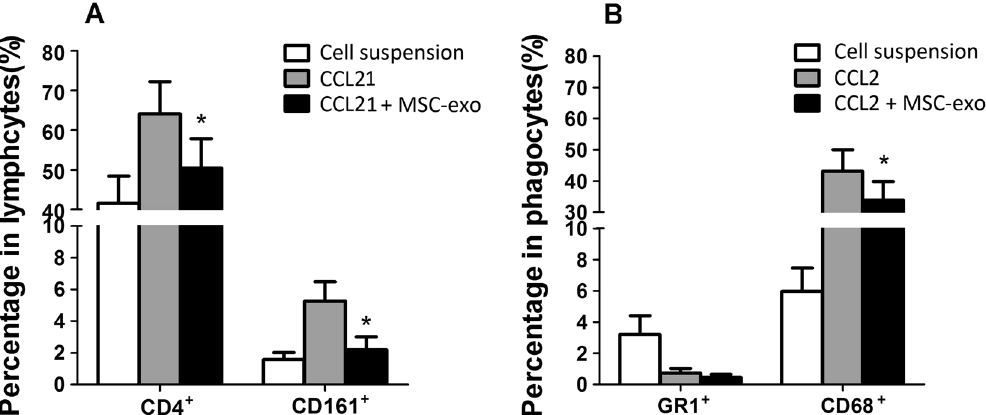
Figure 7. The effect of MSC-exo on the chemotaxis of leukocytes. IRBP-specific spleen monocytes prepared from immunized rat on day 12 post immunization were stimulated for 2 days with R16, and then added to the upper well of a microchemotaxis device and incubated in RPMI 1640 medium containing CCL2 or CCL21 with or without MSC-Exo (10 ug/ml). The cells that migrated to the lower well after 4 h were collected and the number of CD4 + ( A ), CD161 + ( A ), CD68 + ( B ) and Gr + ( B ) cells were determined by flow cytometry. * P < 0.05.